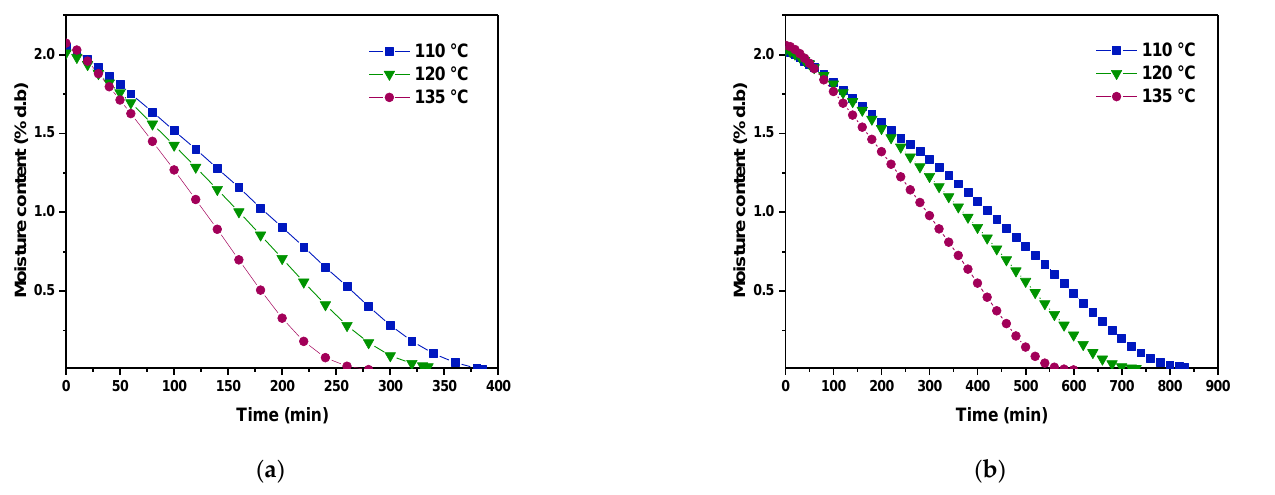
Figure 3. Variation of the moisture content versus time, ( a ): 1 cm and ( b ): 2 cm.